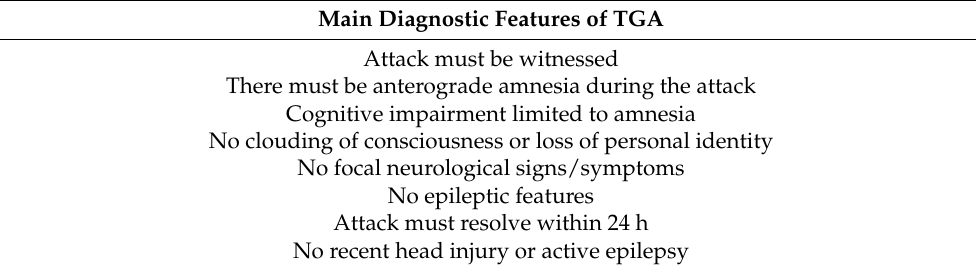
Table 1. Diagnostic criteria for transient global amnesia (data from Hodges JR and Warlow CP 1990) [1,2]. Main Diagnostic Features of